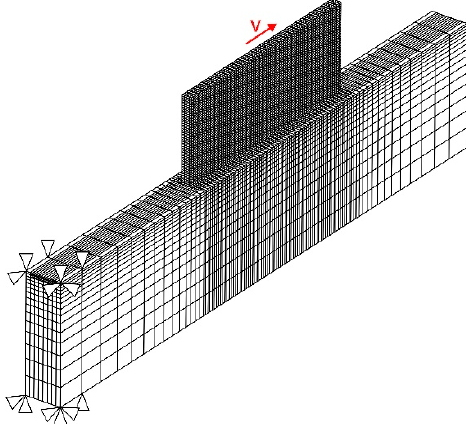
Figure 7. Finite element mesh used for the numerical simulation of DLD process.